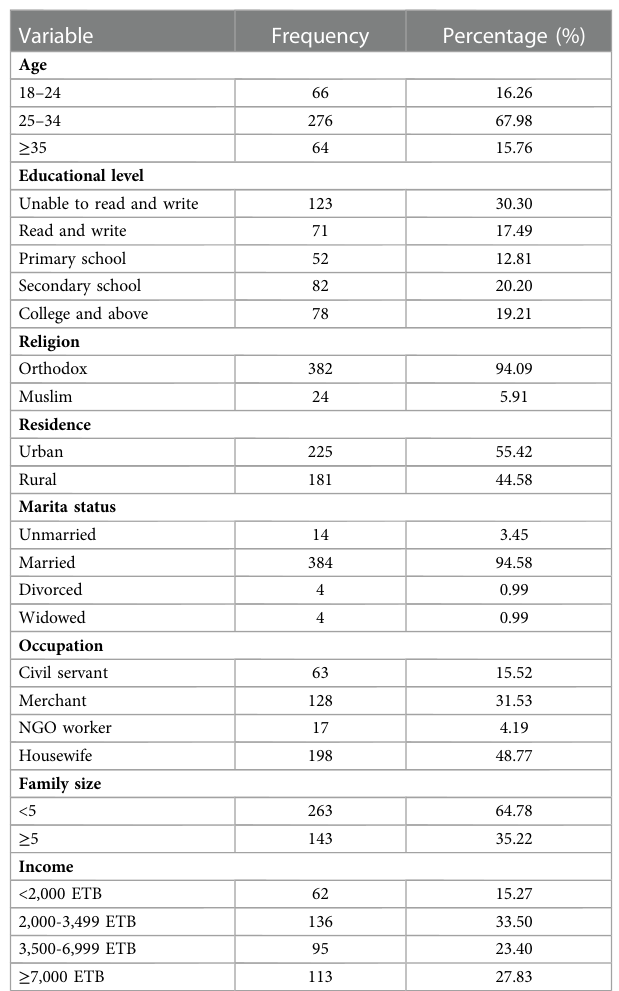
TABLE 1 Maternal socio-demographic characteristics of neonates admitted with sepsis at NICU in referral hospitals of north west Ethiopia, 2021 ( N